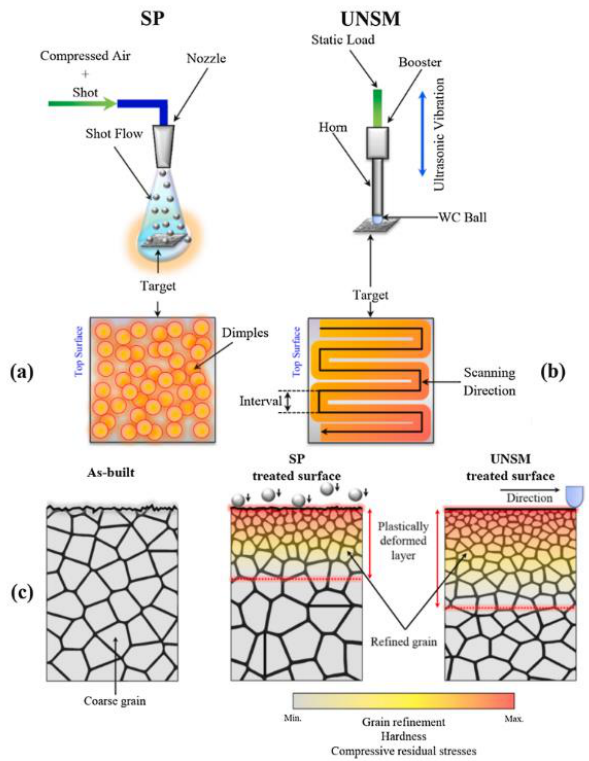
Figure 12. Schematic representation of the SP ( a ) and UNSM ( b ) processes ( c ) and how they affect the surface morphology, grain refinement, surface hardening and residual compressive stresses induced in the surface layer [102].